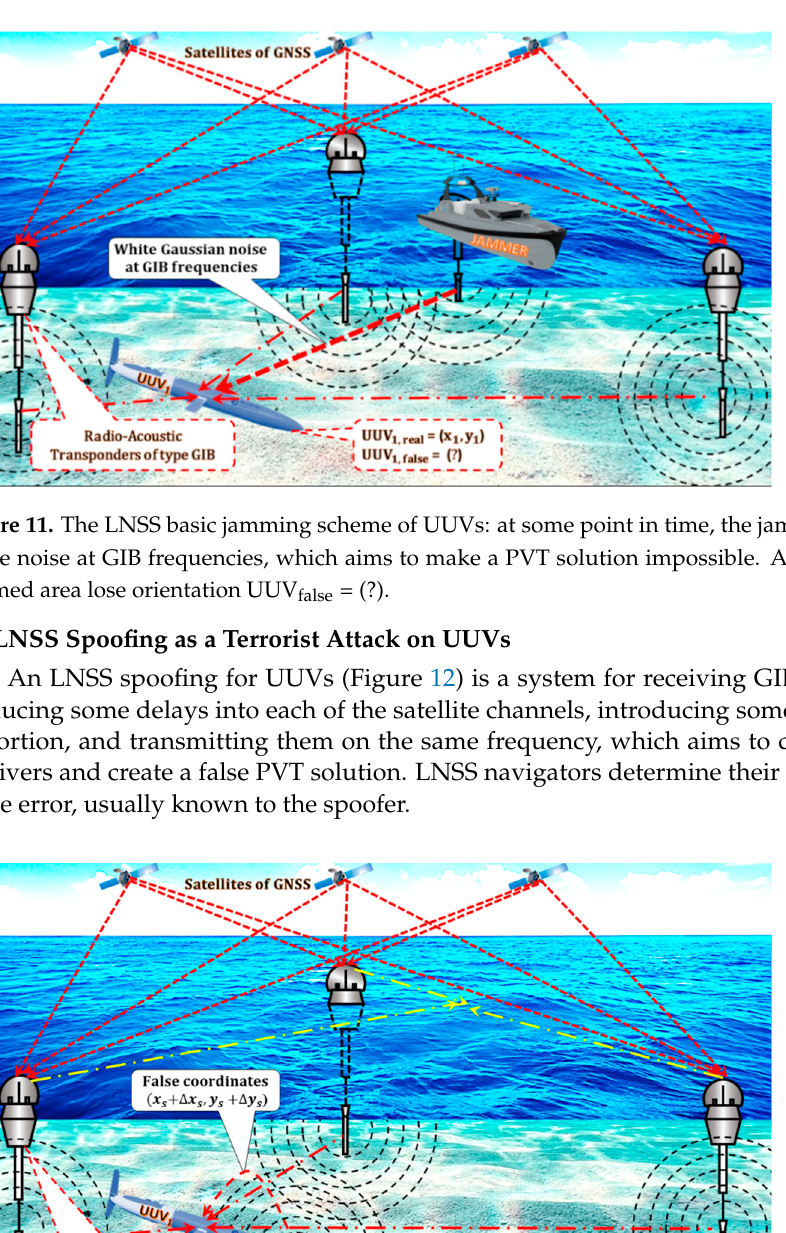
Figure 10. The main idea of LNSS.